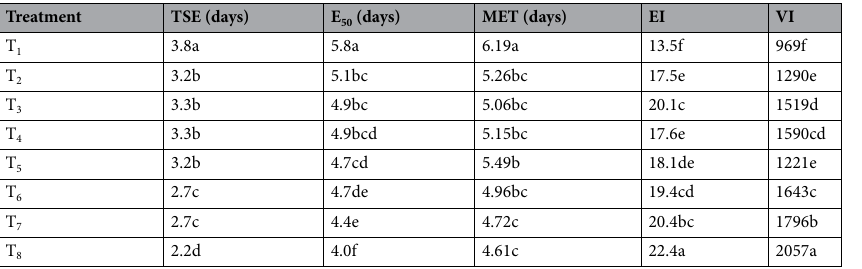
Table 1. Effect of seed priming on seedling emergence and seedling vigour of DSR in a pot experiment (pooled over 2019 and 2020). TSE time to start emergence, E 50 time taken to reach to 50% emergence, MET mean emergence time, EI emergence index, VI Vigour index. T 1 hydro priming or control, T 2 Na-selenite at 50 µmol, T 3 Na-selenate at 50 µmol, T 4 Na-selenite at 50 µmol + Na-selenate at 50 µmol, T 5 ZnO-NPs at 10 µmol,